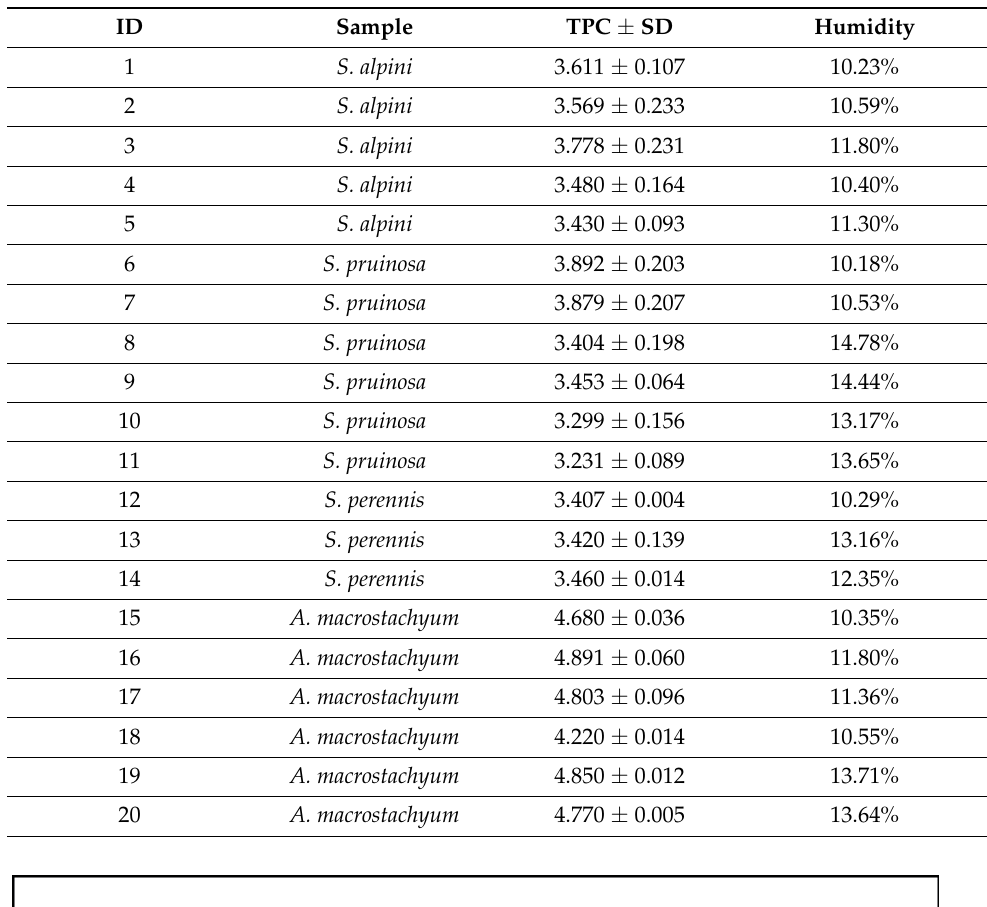
Table 1. Data on the sample weight and total phenolic compounds (TPC ± SD (mg G.A.E./g plant dw)) for dry material and humidity. Note: gallic acid equivalent (G.A.E.) and standard deviation (SD). n = 3.